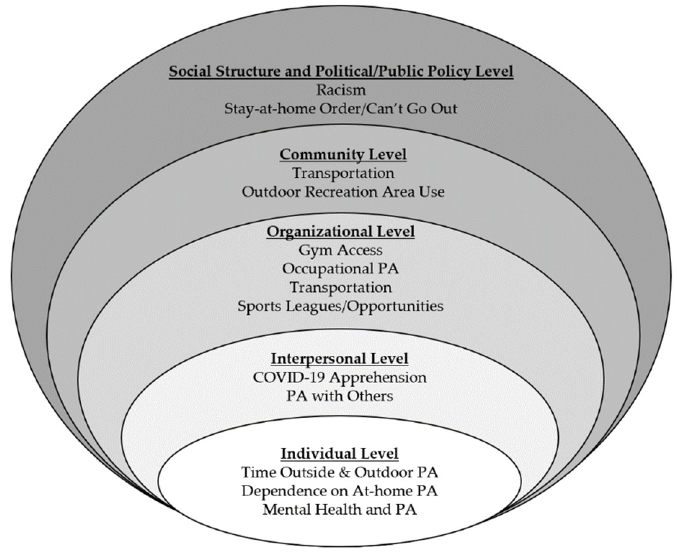
Figure 1. Qualitative Themes Organized based on the Social Ecological Model.